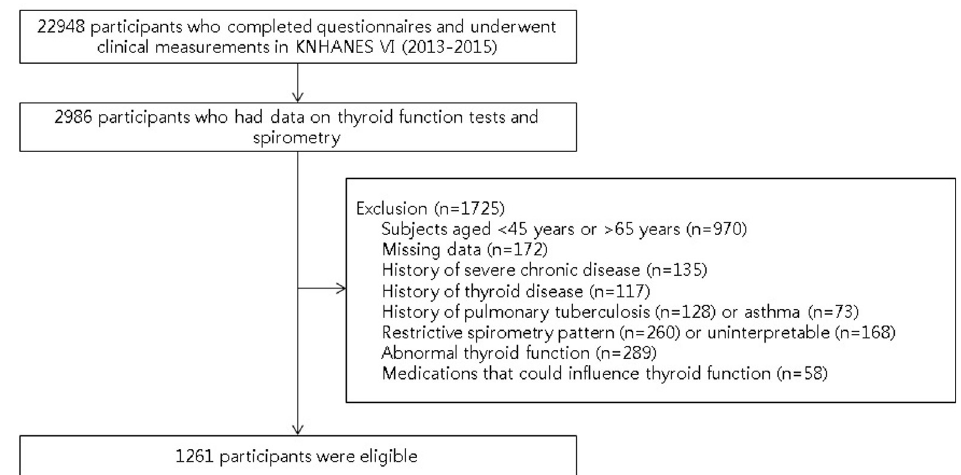
Fig 1. Flow chart of the study population. KNHANES, Korean National Health and Nutrition Examination